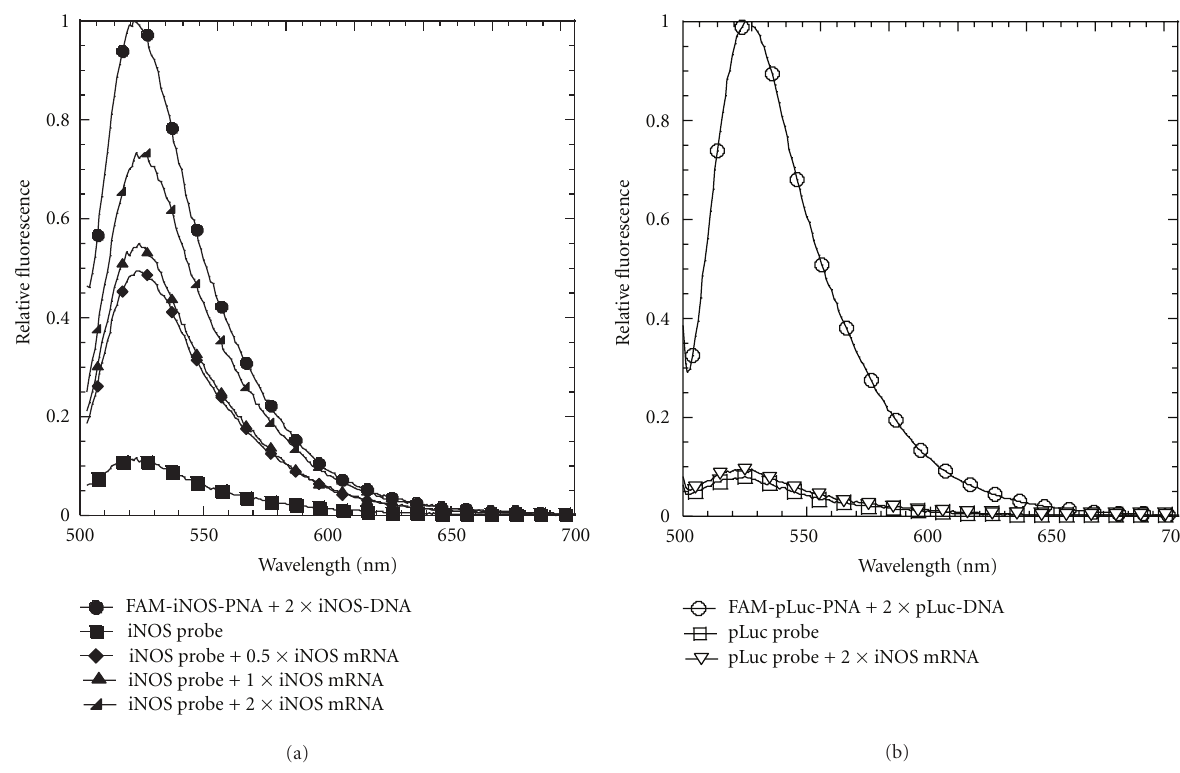
Figure 5: Fluorescence activation of the strand displacement probes by iNOS mRNA.(a) Fluorescence spectra of the iNOS probe (0.2 μ M iNOS-FAM-PNA annealed to 0.4 μ M iNOS-DNA-DABCYL) in the presence of 0.1, 0.2, and 0.4 μ M iNOS mRNA. Positive control: 0.2 μ M iNOS-FAM-PNA annealed to 0.4 μ M iNOS-DNA. (b) Fluorescence spectra of the pLuc probe (0.2 μ M FAM-pLuc-PNA annealed to 0.4 μ M pLuc-DNA-DABCYL) in the presence of 0.4 μ M iNOS mRNA. Excitation wavelength 488 nm. Temperature: 37 ◦ C.